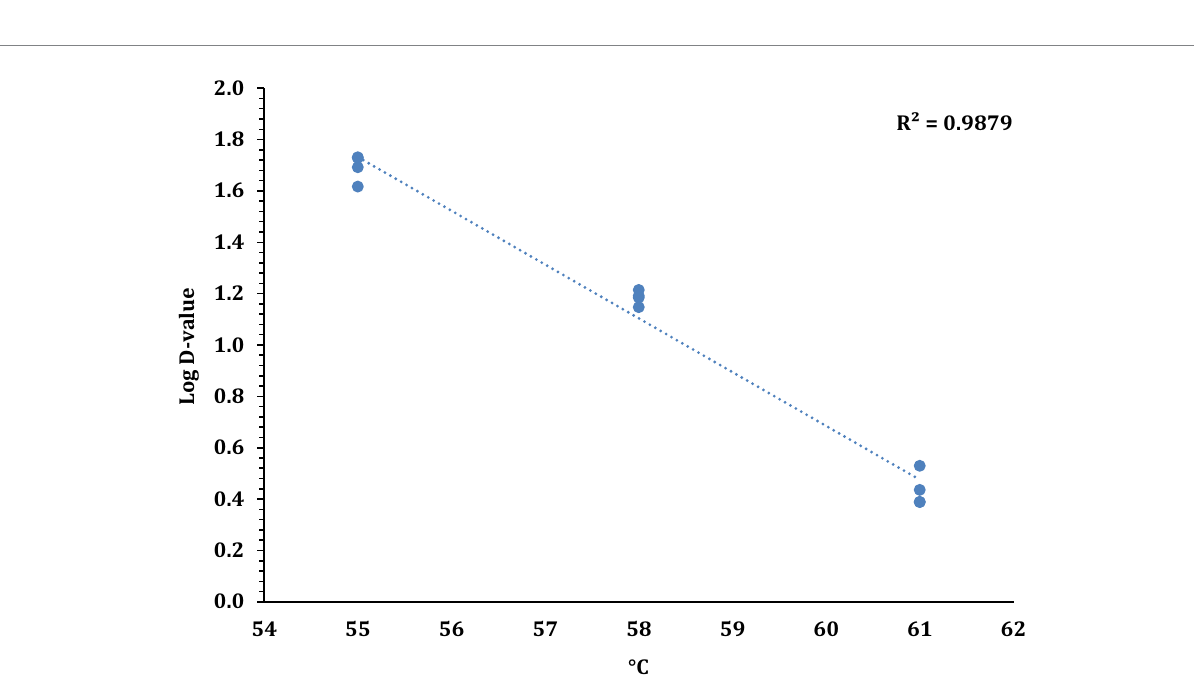
FIGURE 8 Log D -values (mean and three replications) versus temperature ( ° C) graphs used for calculating z -values for